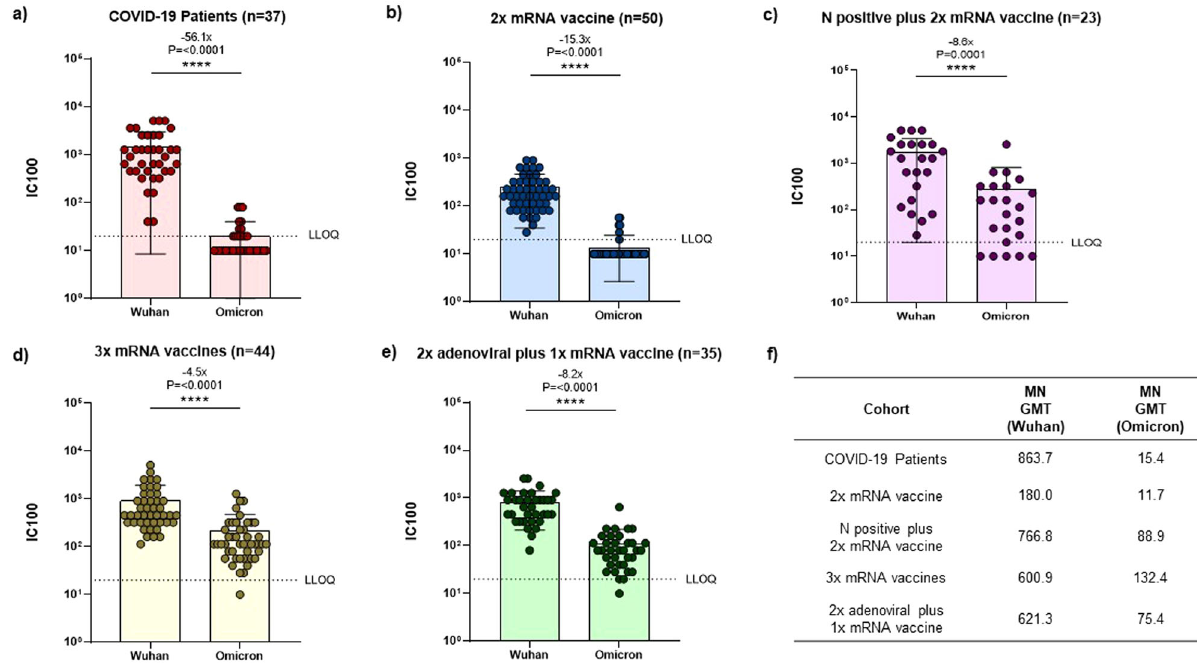
Fig. 2 Neutralization titers against ancenstral (Wuhan WT) or Omicron BA.1 live virus. a Hospitalized COVID-19 patients (37 subjects); b SARS-CoV-2- naïve vaccinees immunized with two doses of homologous mRNA vaccine (49 subjects); c previously infected subjects who had received a double dose of homologous mRNA vaccine (23 subjects); d vaccinees boosted with a third dose of mRNA after completion of primary double-dose vaccination with mRNA-based (homologous) vaccine (44 subjects); e vaccinees boosted with a third dose of mRNA after completion of primary double-dose vaccination with adenovirus-based (heterologous) vaccination (35 subjects); f Neutralization (MN) Geometric Mean titers (MN GMTs) for each cohort and for ancestral virus and Omicron BA.1 variant. Data points show individual serum neutralization titers (average of two replicates). The neutralization titer is represented as the highest serum dilution able to inhibit 100% of virus-induced CPE (100% inhibitory serum dilution (IC100)). MN GMTs for each cohort are shown. Error bars indicate the GMT of the group ± standard deviation. Fold-changes in GMT are reported above histograms. P values were calculated by means of the Mann – Whitney U-test. Horizontal dashed line represents the Lower Limit of Quanti fi cation (LLOQ) of the